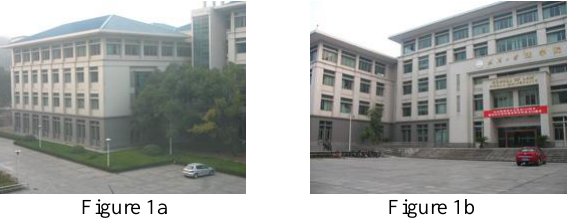
Figure 1: Given image and building where the image was taken The problem is defined as ‘space resection’ in photogrammetry community and ‘pose estimation’ or ‘extrinsic